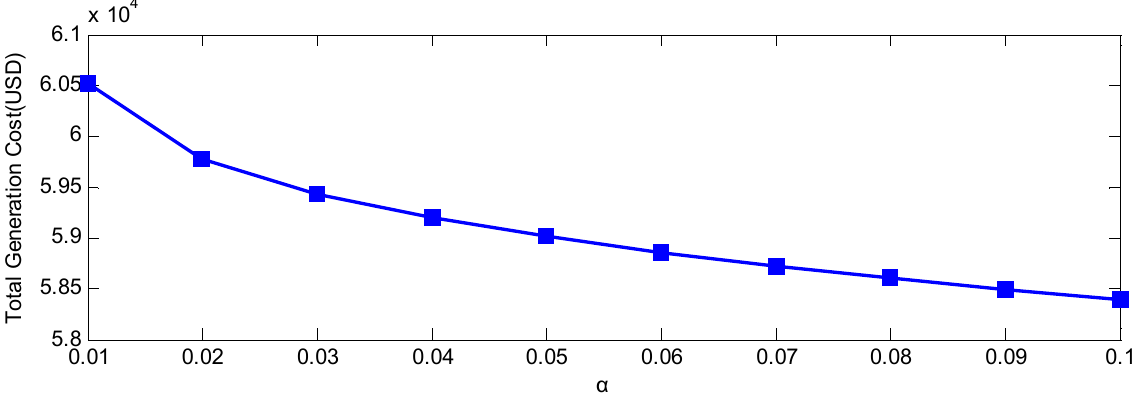
Figure 3. The scheduled wind power output as a function of 